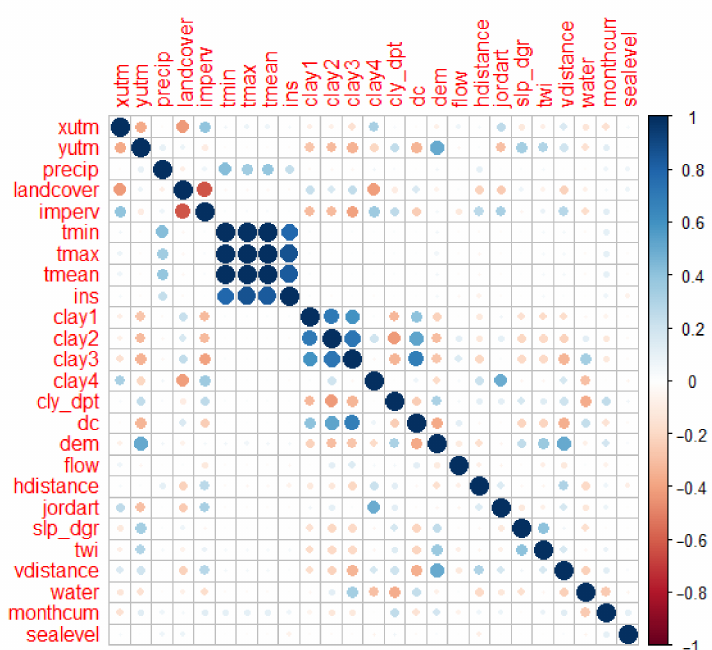
Figure 2. Correlation matrix for assessing the correlation between variables, from 1 to − 1 (xutm and yutm = coordinates, precip = monthly average precipitation, landcover = Corine landcover, imperv = imperviousness, tmin and tmax = minimum and maximum temperature, tmean = monthly average temperature, ins = incoming solar radiation, clay 1–4 = clay content, cly_dpt = depth to clay, dc = soil drainage class, dem = digital elevation model, flow = flow accumulation, hdistance = horizontal distance to water body, jordart = soil type, slp_dgr = slope, twi = topographic wetness index, vdistance = vertical distance to water, water = water bodies, monthcum = cummulative time in months, sealevel = sea